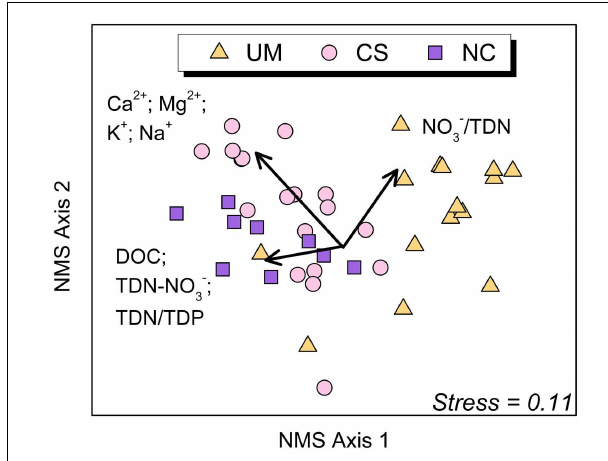
FIGURE 3 | Non-metric multidimensional scaling (NMS) ordination (first and second of the 3-dimensional solution) of stream sediment bacterial communities ( n = 42) based on pairwise similarity estimates (Bray–Curtis). Points that are close together represent communities with similar bacterial community composition based on theT-RFLP method. Groupings show significant (ANOSIM Global R = 0.40; P < 0.001) separation by lithology (orange triangles = Ultramafic (UM); pink circles = Complex Sedimentary (CS); purple squares = Non-carbonate (NC). The associated normal stress value of the ordination is 0.11, indicating a good approximation of the overall structure of the data in multivariable space. Significant ( P < 0.005), Bonferonni adjusted biogeochemical variables were overlaid (arrows) showing the degree of correlation with sediment data. Abbreviations:TDN-NO − (total dissolved nitrogen minus 3 nitrate, an indication of dissolved organic nitrogen);TDN/TDP (ratio of total dissolved nitrogen to total dissolved phosphorus); DOC (dissolved organic carbon); Base Cations = Ca 2 + , Mg 2 + , K + , and Na + ; and NO − /TDN (ratio of 3 nitrate to total dissolved nitrogen).